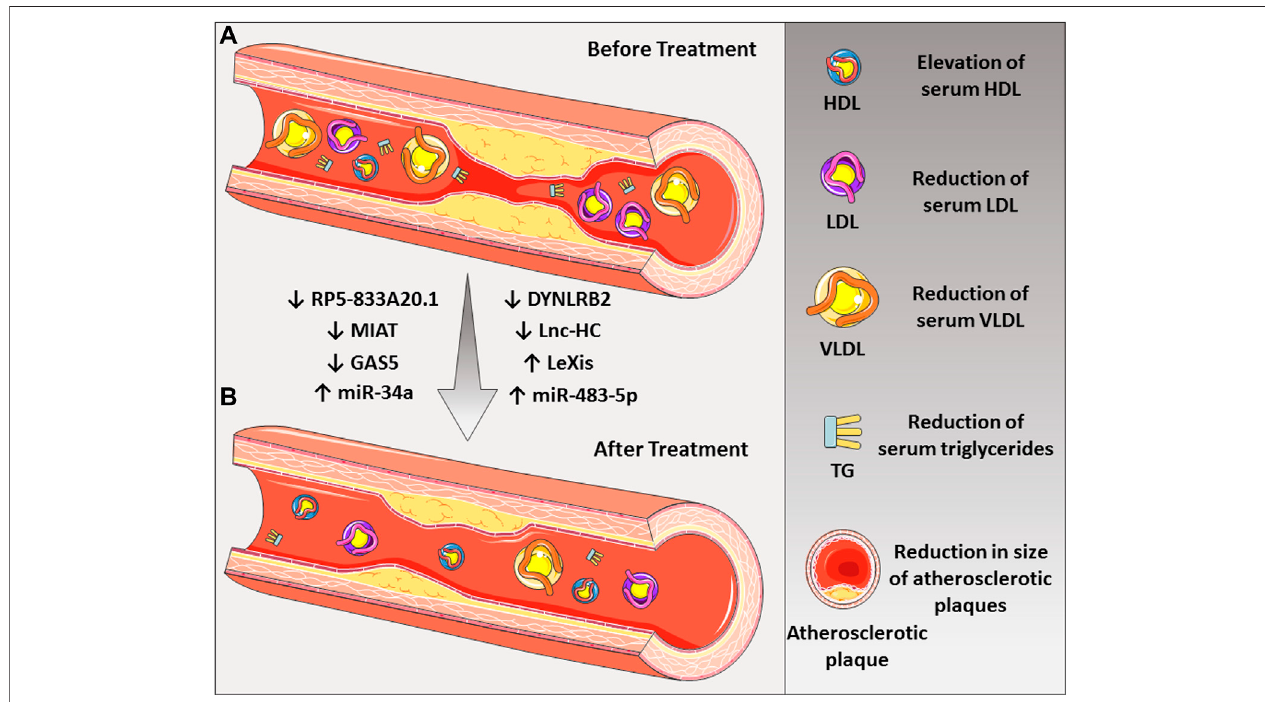
FIGURE 2 | The roles of various noncoding RNAs in the treatment of atherosclerotic disease. (A) Down-regulation of some lncRNAs such as MIAT, GAS5, RP5- 833A20.1, DYNLRB2, and Lnc-HC and (B) up-regulation of LeXis lncRNA could lead to the reduction of LDL-C and atherosclerotic plaque. Also, up-regulation of miR- 34a and miR-483-5p could be bene fi cial in the treatment of the disease.